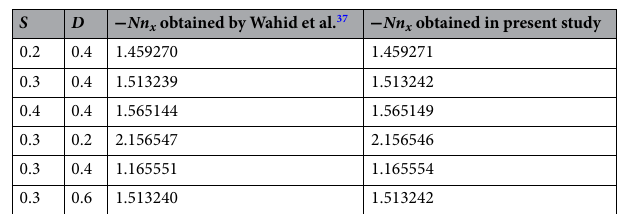
Nn x with existing results of Wahid et al. 37 −